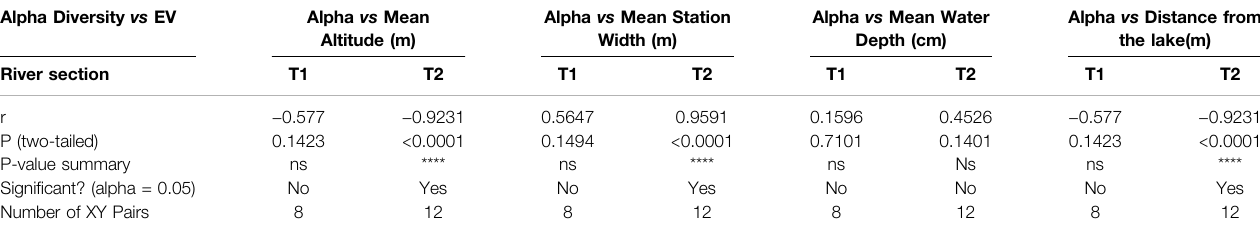
TABLE 5 | Spearman correlations of alpha diversity and environmental